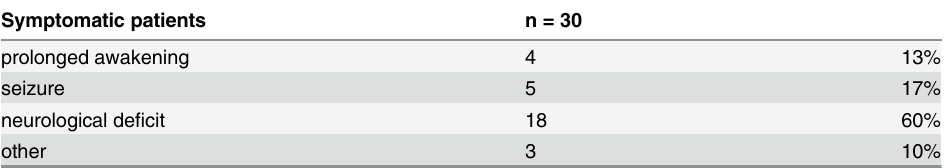
Table 1. Distribution of initial symptoms of symptomatic patients.